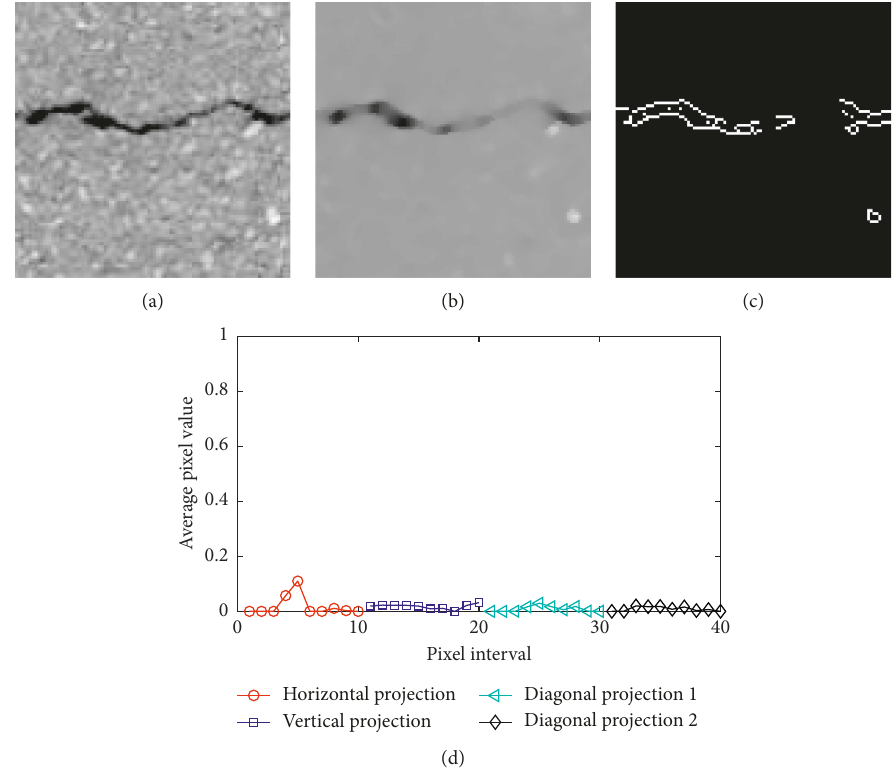
Figure 5: PIs of an image yielded from the SBF response. (a) Pavement image. (b) FBF. (c) STF. (d) Projective